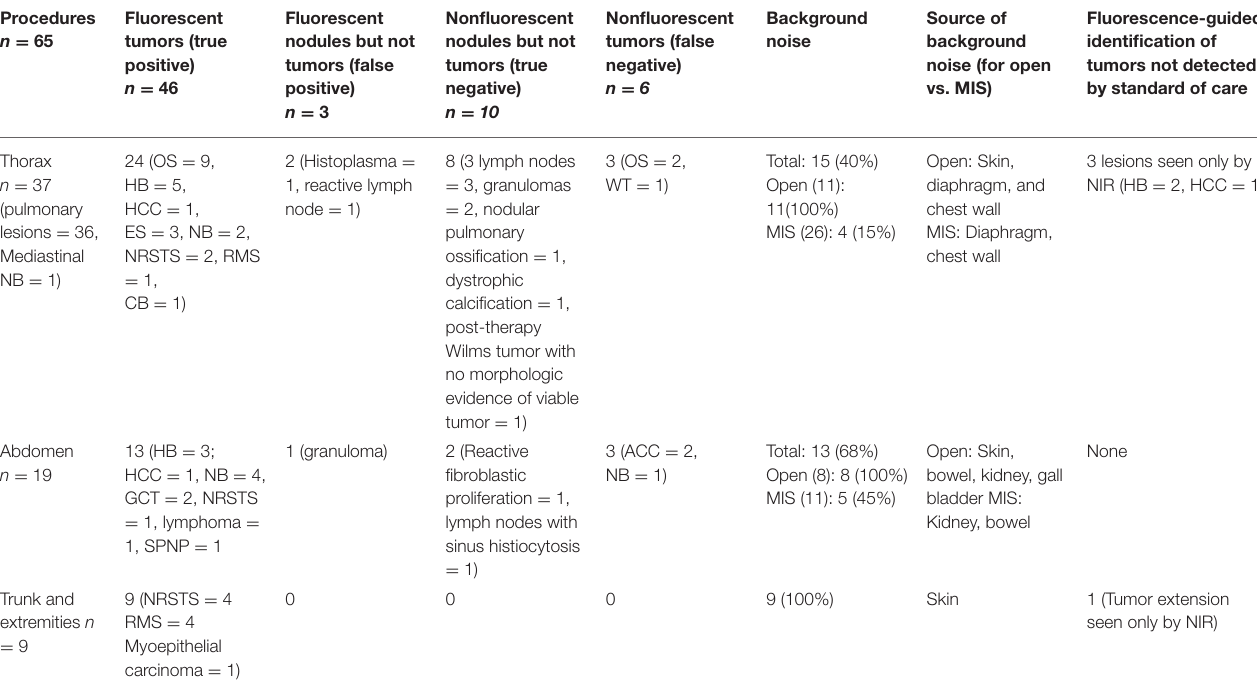
TABLE 1 | Tumor localization with ICG: utility, dosing, dosing interval, and challenges. Procedures n = 65